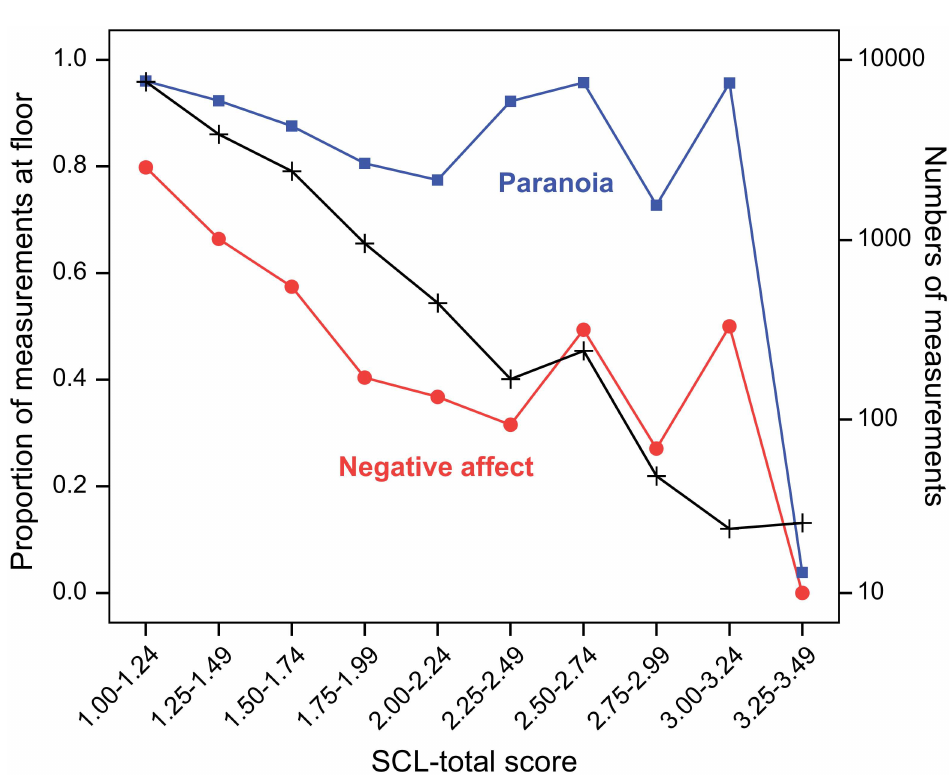
Fig 3. Floor effects of negative affect (NA) and paranoia (PAR) by SCL-total score level. Proportions of mental state (NA and PAR) scores at the floor of their scales by overall severity of psychopathology(SCL- total score). The red curve represents the proportions of floor scores for NA, whereasthe blue line represents the same for PAR (scale on the left). Numbers of measurements by overall severity are displayed in the black line (scale on the